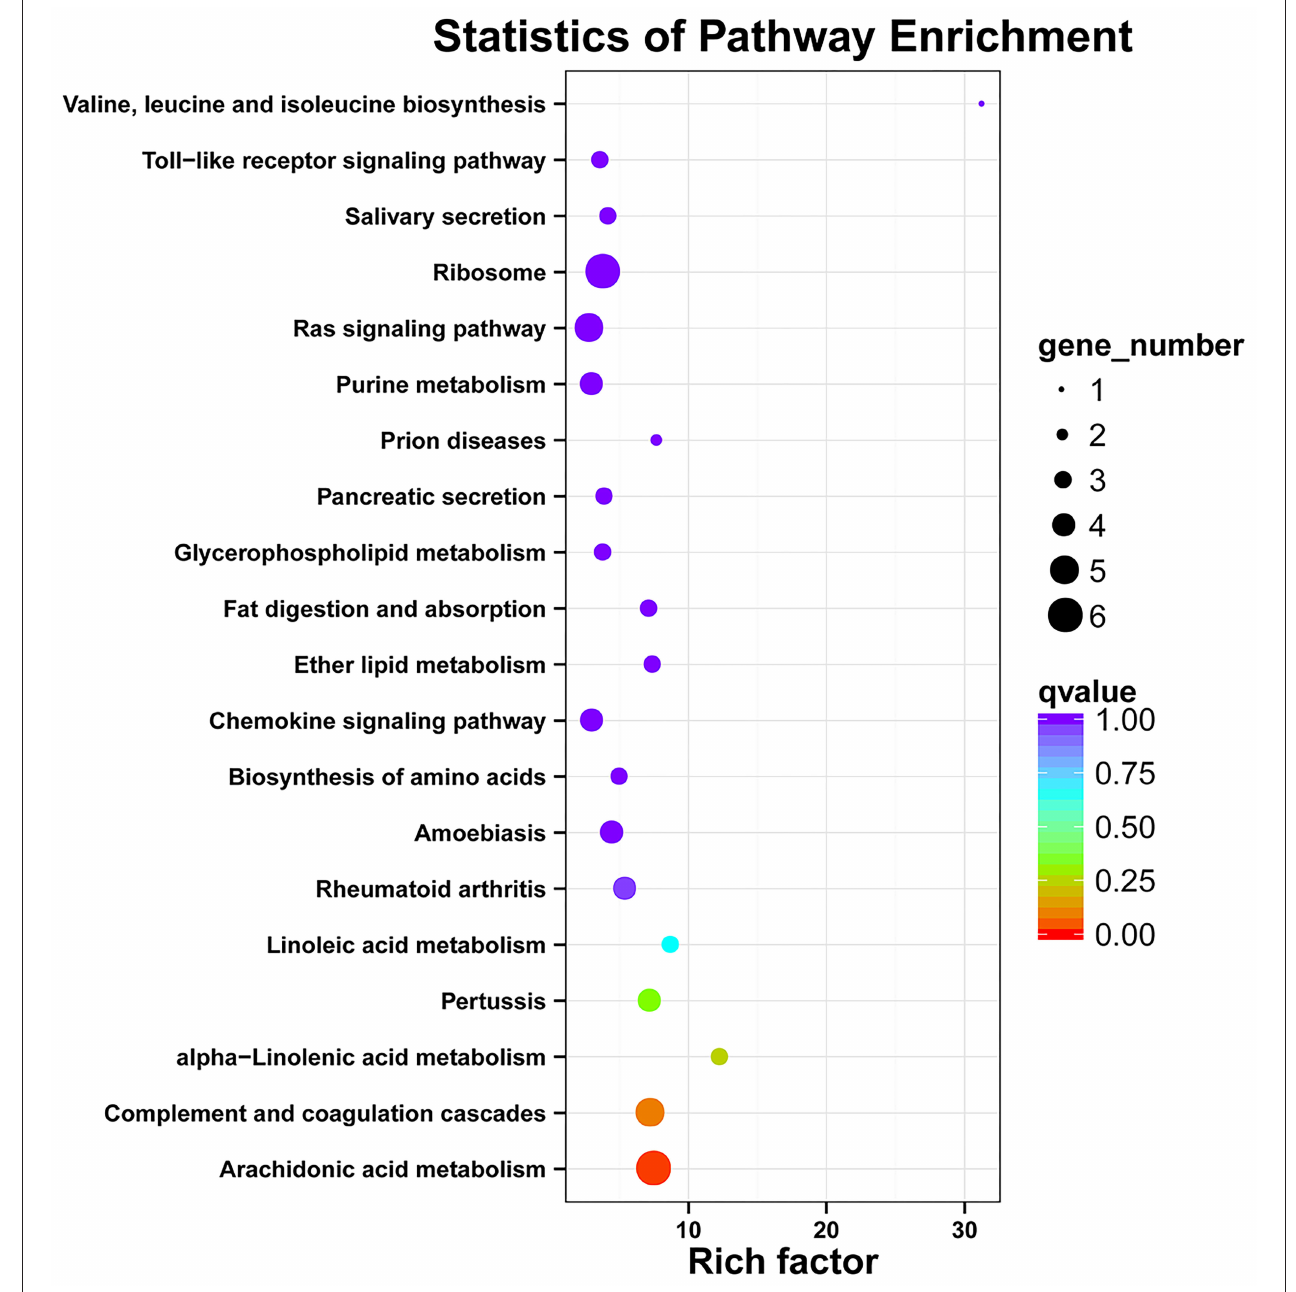
FIGURE 4 | KEGG enrichment analyses of the down-regulated DEGs in jejunum of neonatal goats suffering from diarrhea as compared with control goat kids. The vertical axis represents the pathway category, and the horizontal axis represents Enrichment Factor which means the proportion of DEGs annotated to the pathway on genes annotated to the